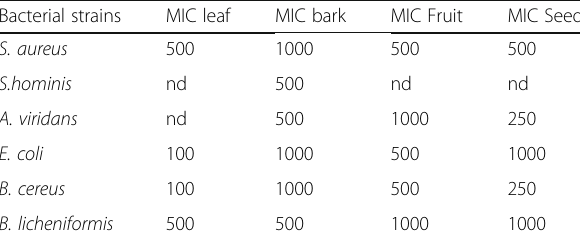
Table 5 Minimum inhibitory concentration (MIC) of leaf, bark, fruit pulp and seed methanol extracts against pathogenic bacteria Bacterial strains MIC leaf